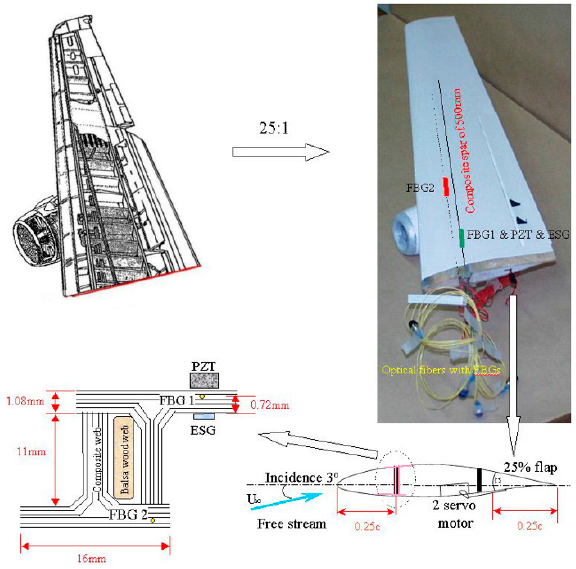
Figure 17. Configuration and geometry of the wing [77].